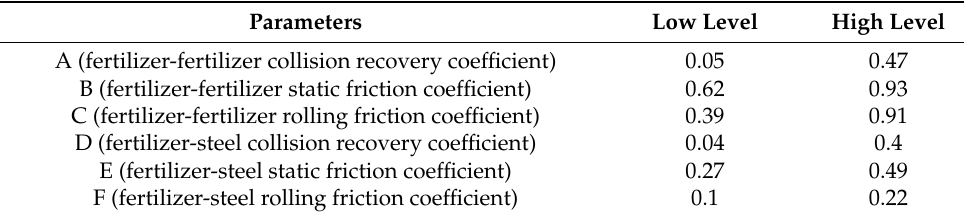
Table 2. Parameter levels of Plackett-Burman